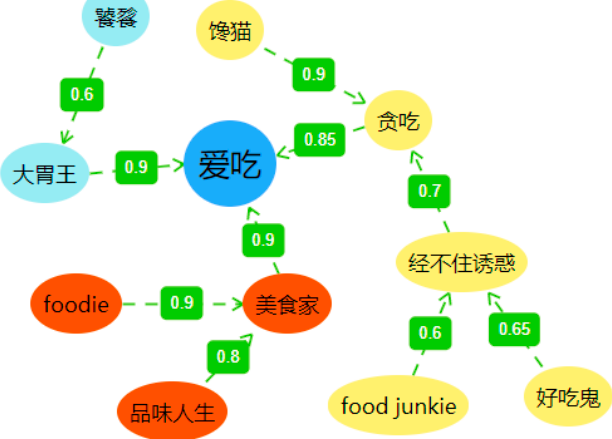
Figure 7. the Synonym Knowledge Graph of “loves to eat”. Figure 7. The Synonym Knowledge Graph of “loves to